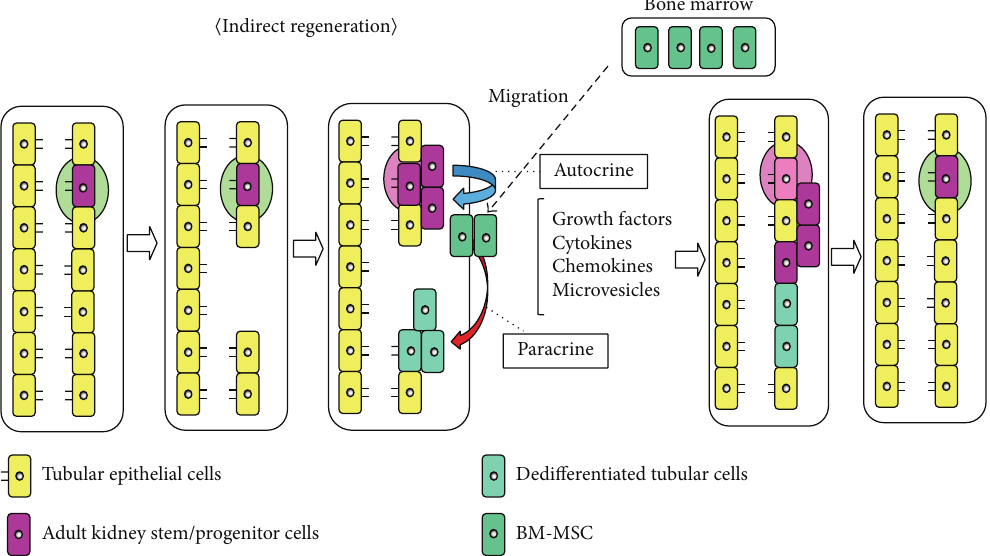
Figure 1: Shema of indirect therapeutic mechanism of stem cells against AKI. Not only the cell proliferation of stem/progenitor cells but also indirect factors such as growth factors, cytokines, chemokines, microvesicles et al. ameliorate injuryed tubular cells.